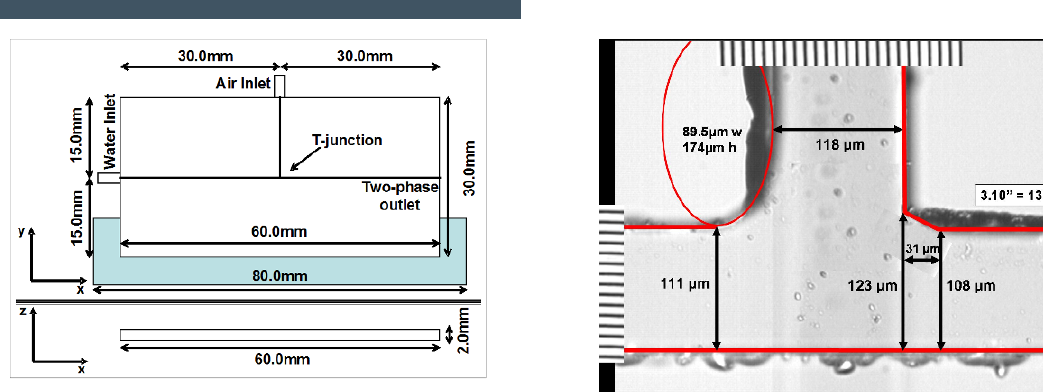
Figure 3. Microfluidic T-junction dimensions